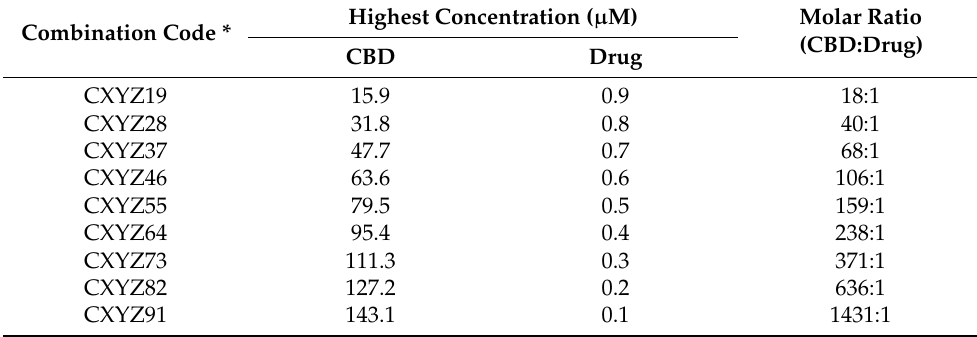
Table 5. Molar ratios, concentrations, and codes of cannabidiol (CBD)